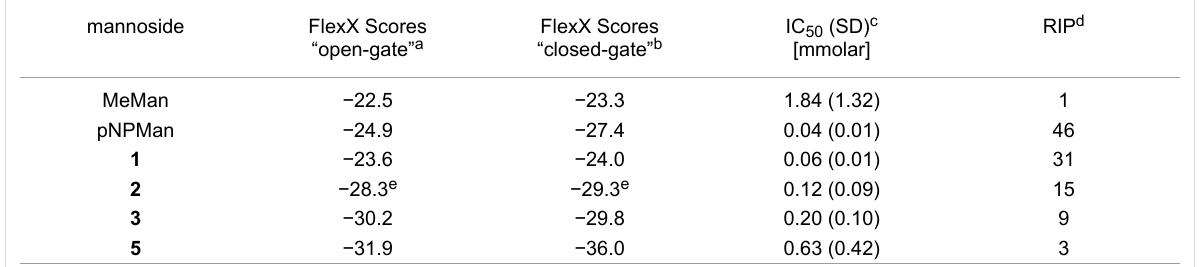
Table 1: Binding of mannoside ligands to FimH was predicted by computer-aided docking (FlexX) and measured by ELISA utilizing type 1-fimbriated E. coli . IC 50 -values are averaged from three independent experiments.